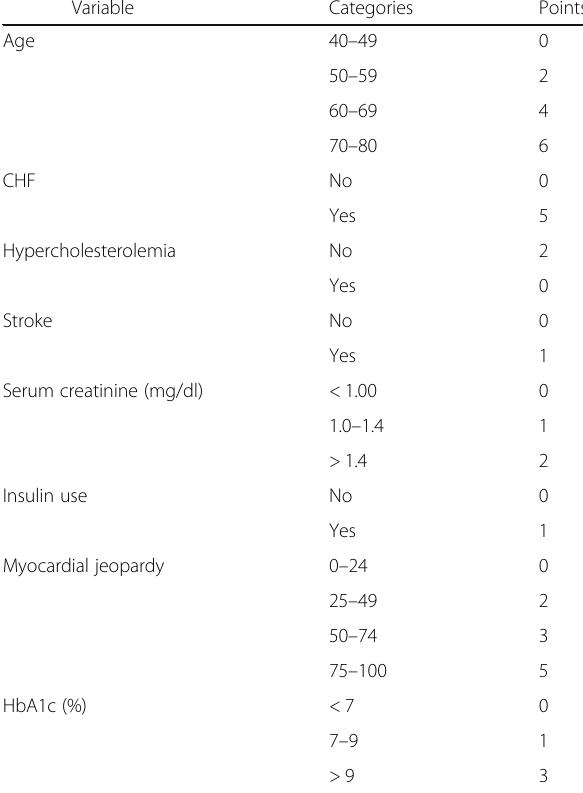
Table 3 Final model coefficients Variable